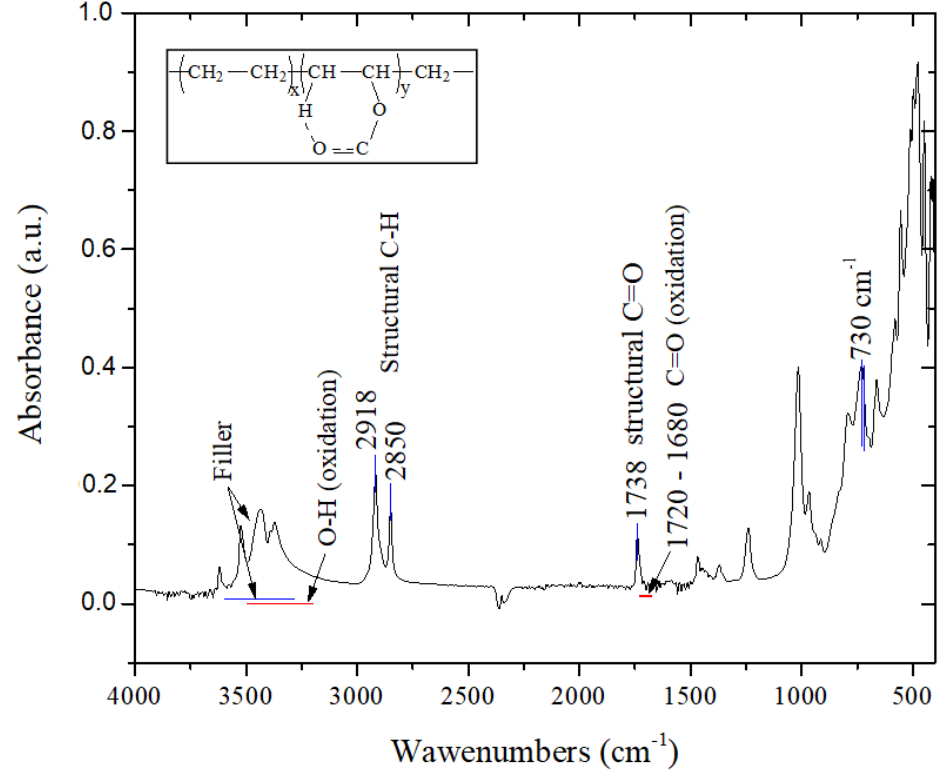
Figure 9. ATR-FTIR spectrum of the EVA jacket of IC2 cable with significant bands. Inset: internal hydrogen bond in vinyl-acetate groups.